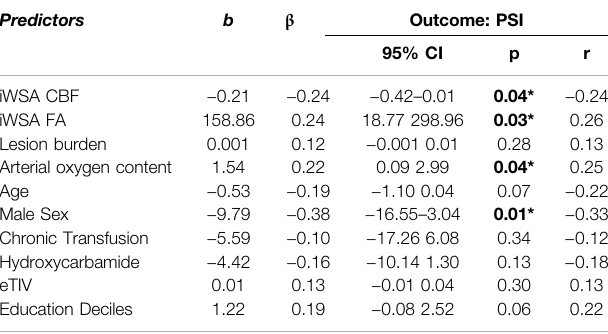
TABLE 2 | Regression Models. Values are unstandardised regression coef fi cients (b), standardised regression coef fi cients ( β ), probability values (p), partial correlation coef fi cients (r), and 95% con fi dence intervals (CI) from regression modelsinpatientswithsicklecellanemia(SCA).Abbreviations:multiTI,multiin fl ow time sequence; CBF, cerebral blood fl ow; iWSA, individual watershed areas; eTIV, estimated total intracranial volume. Signi fi cant predictors are shown in